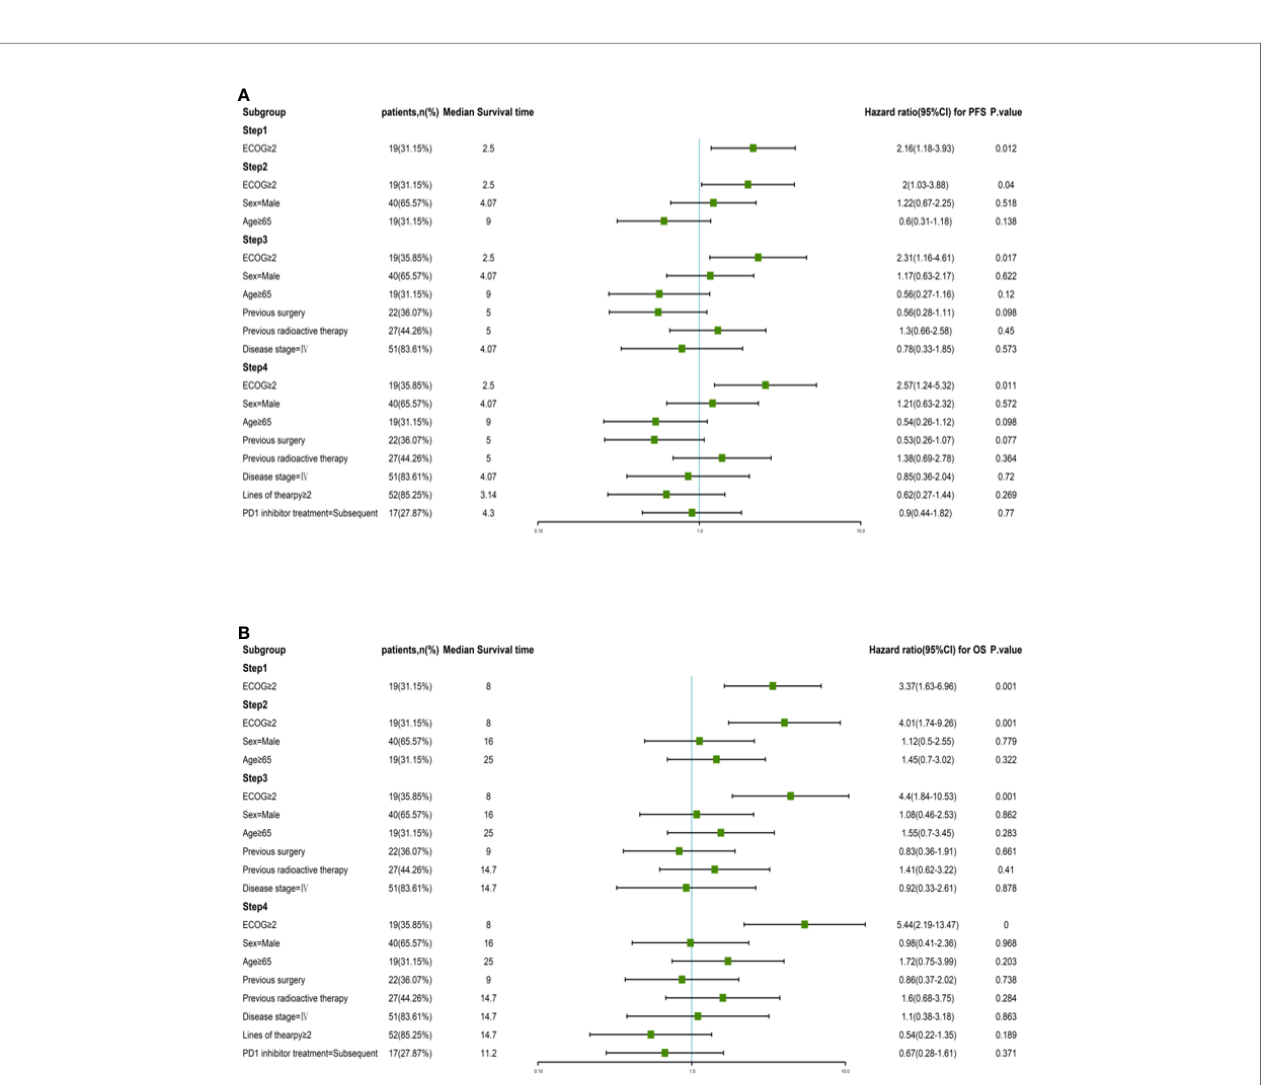
FIGURE 4 | Risk factor analysis by Kaplan-Meier calculations and Cox proportional hazards models. (A) PFS and corresponding hazard ratios at different risk factors in all patients. (B) OS and corresponding hazard ratios at different risk factors in all